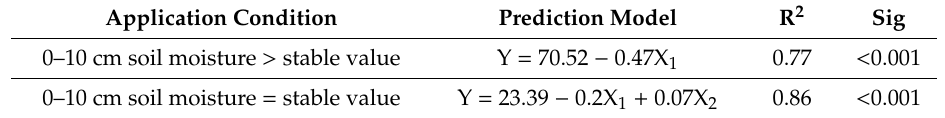
Table 3. Estimation models of the 0–10 cm soil moisture.